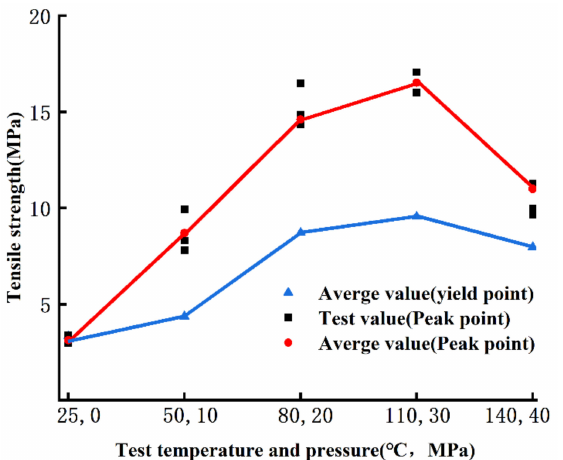
Figure 7. The evolution of tensile strength with the increase of test temperature and confining pres-